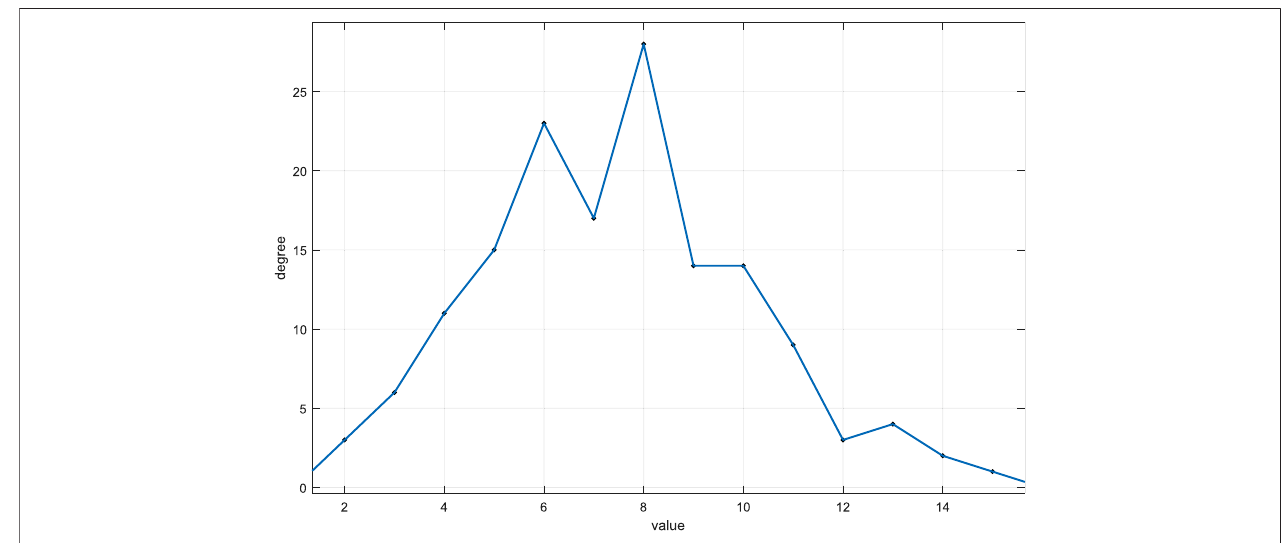
FIGURE 4 | Distribution of the cellular network.